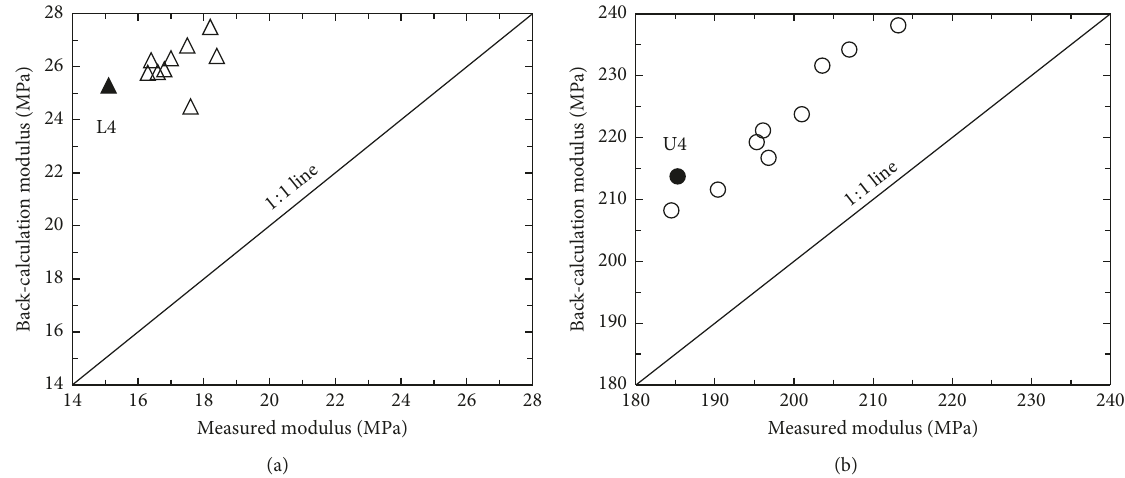
Figure 6: Comparison of back-calculated moduli using LEM and measured moduli using PLT. (a) Results of L1–L10. (b) Results of U1–U10.